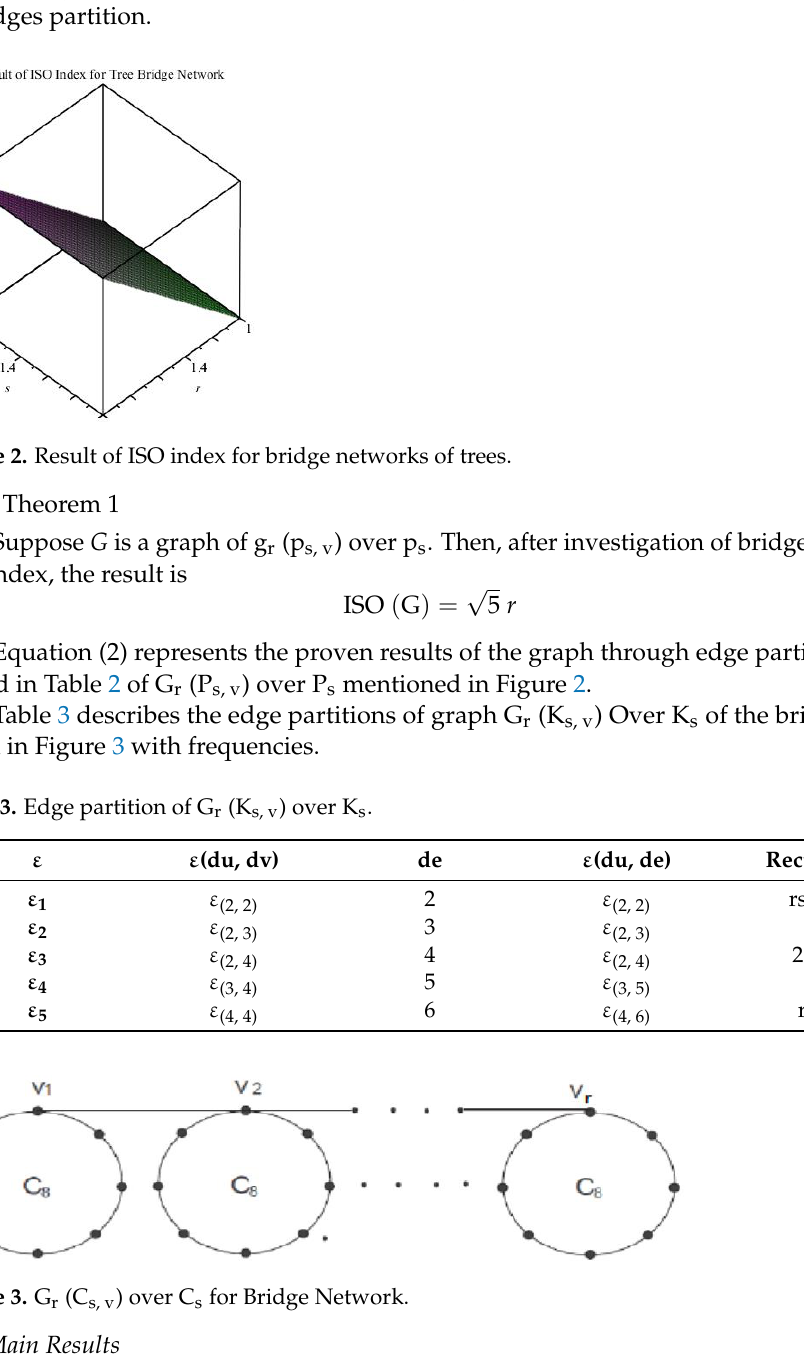
Figure 3. G r (C s, v ) over C s for Bridge Figure 3. G r (C s , v ) over C s for Bridge Network. Table 3. Edge partition of G r (K s , v ) over K s .